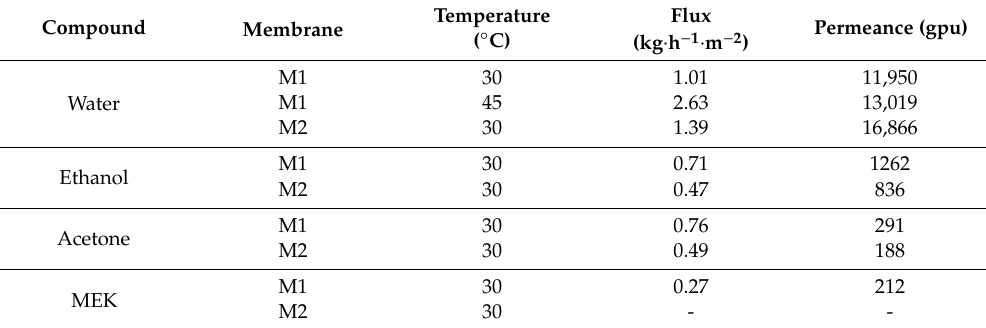
Table 3. Summary of pure flux and permeance through M1 and